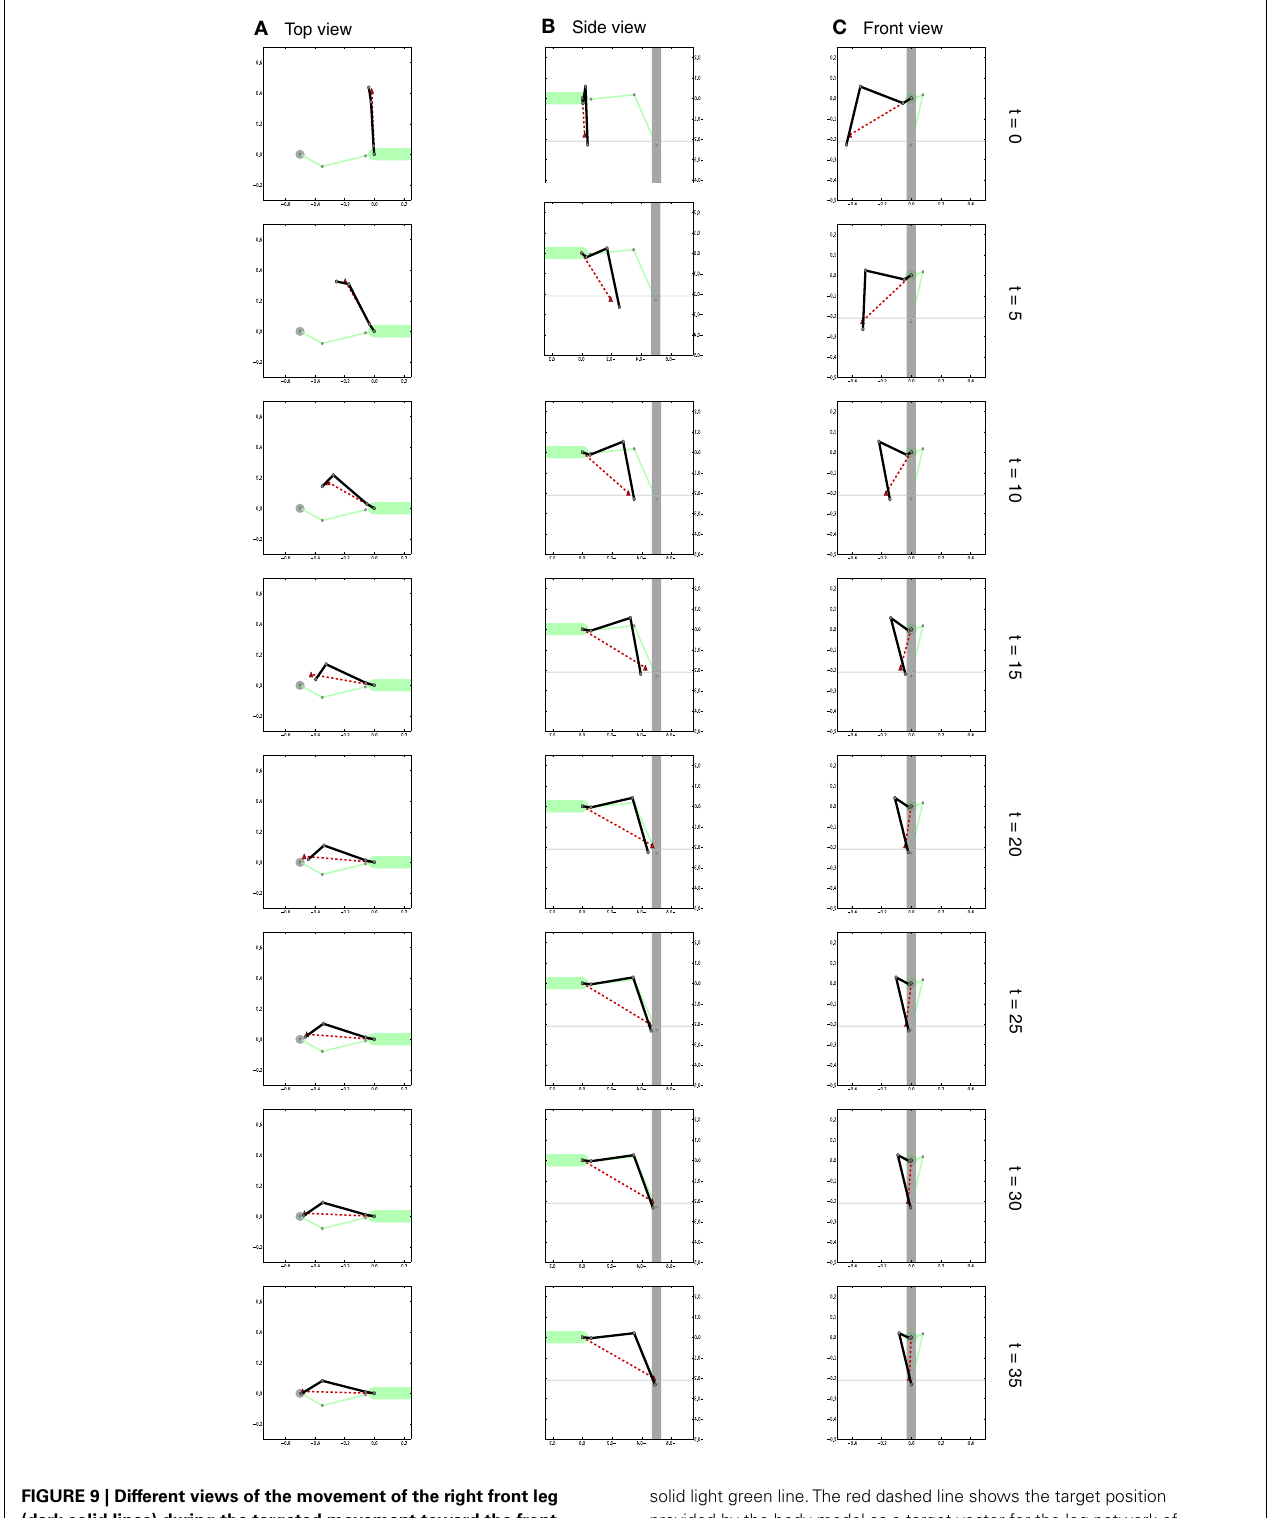
FIGURE 9 | Different views of the movement of the right front leg (dark solid lines) during the targeted movement toward the front. [Views as shown in Figure 6 . Note that as we are looking at the right leg in (B) we are looking from the other (the right) side.] Shown is the movement over time.The configuration of the left leg is shown as a